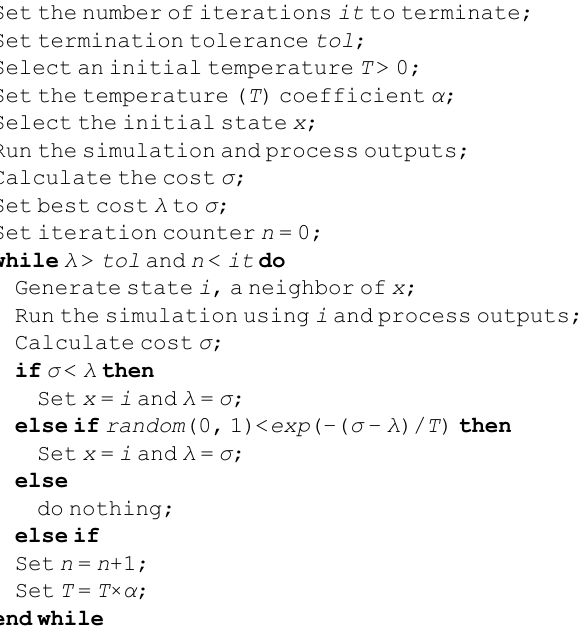
Algorithm 1 is tested against two cost (fitness) functions measuring: (i) Diffusion Speed